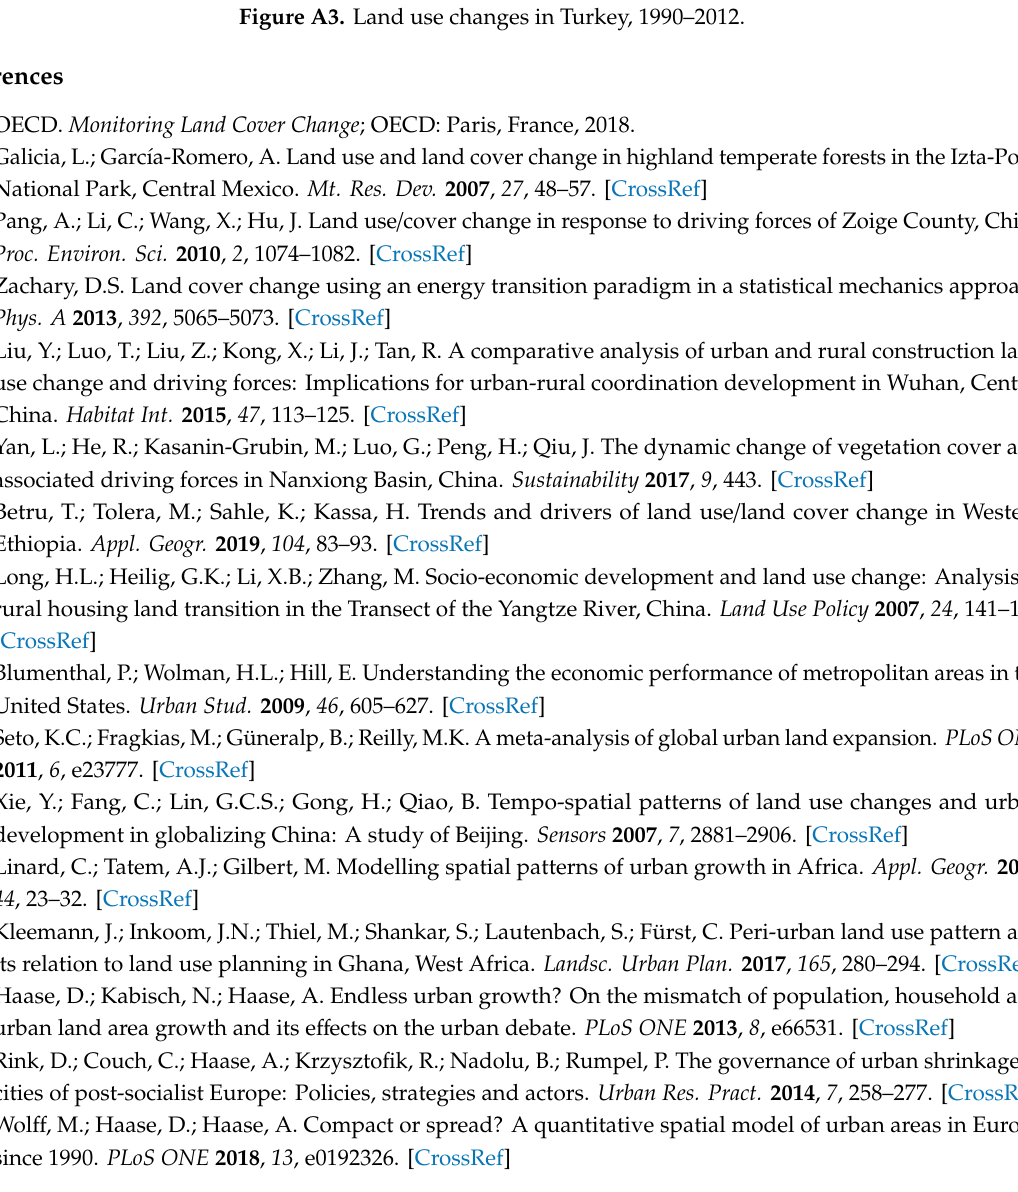
Figure A3. Land use changes in Turkey, 1990–2012.